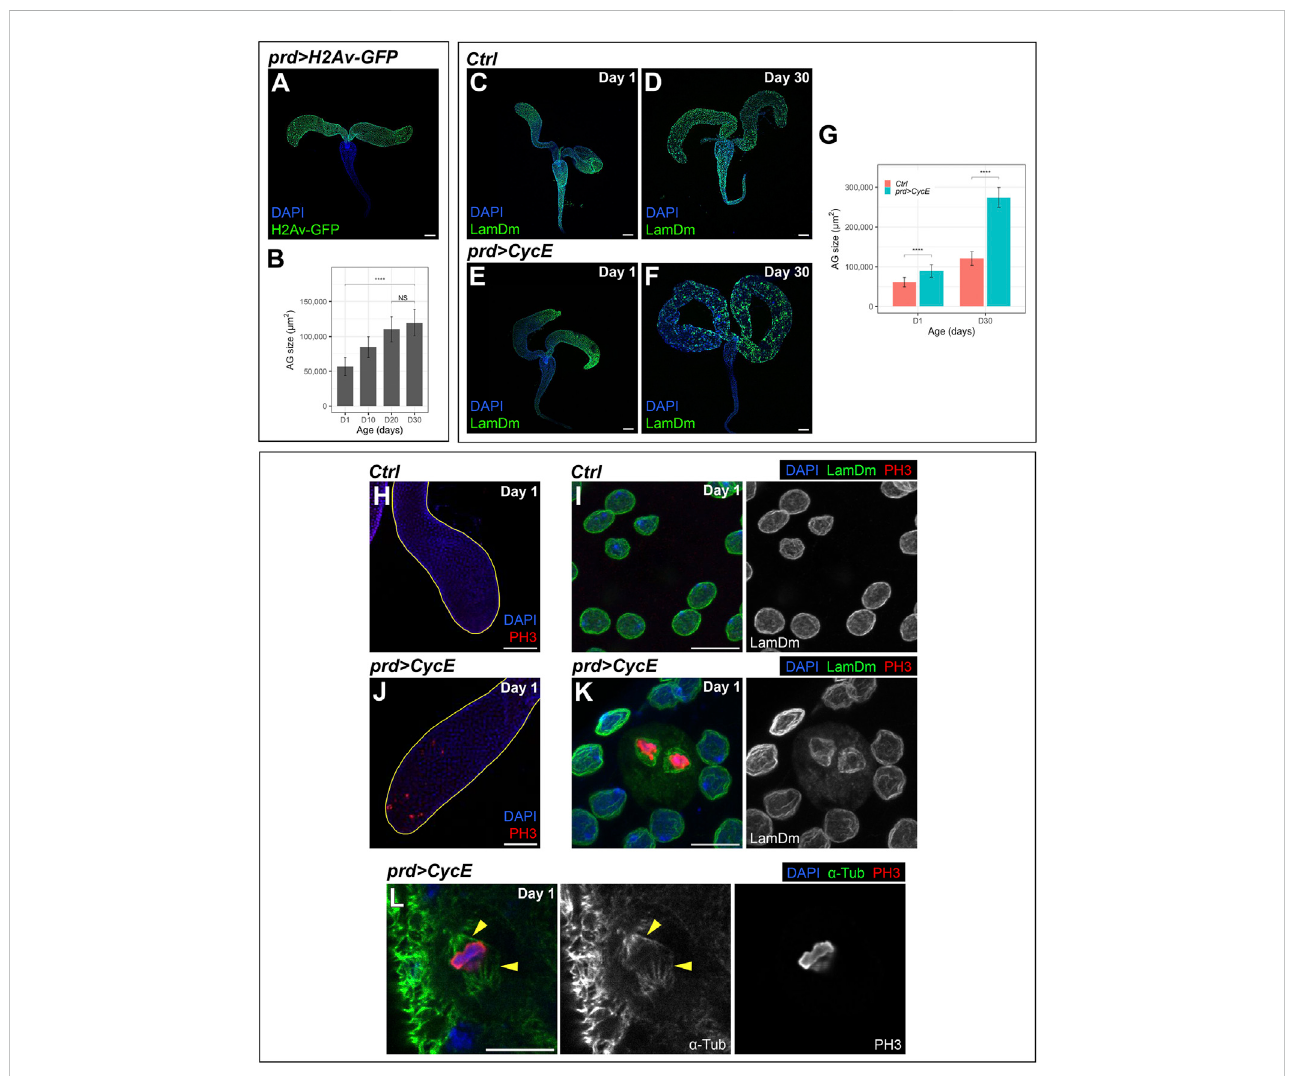
FIGURE 1 Cyclin E upregulation drives a size increase in the accessory gland. (A) Confocal image of an accessory gland that expresses H2Av-GFP under prd-Gal4 control. DAPI and H2Av-GFP are shown in blue and green, respectively. Scale bar, 100 µm. (B) Quanti fi cation of yw accessory gland (AG) size at days 1, 10, 20and30.Datashownaremean±SD.Statisticalanalysiswasperformedusingaone-wayANOVAfollowedbyaTukey ’ sHSDtest.Onlytherelevantsigni fi cant changes are shown. ****, p < .0001. NS, non-signi fi cant. (C – G) Confocal images of 1-day-old and 30-day-old control ( prd-Gal4/+ ) [ (C,D) , respectively] and prd > CycE [ (E,F) , respectively] accessory glands, and their size quanti fi cation (G) . Note that images in (C,E) were re-sized to have the same magni fi cation as (D,F) . In (C – F) , DAPI and LamDm are shown in blue and green, respectively. Data shown in (G) are mean ± SD. Statistical analysis was performed using a two-way ANOVA followed by a Tukey ’ s HSD test. Only the relevant signi fi cant changes are shown. ****, p < .0001. Scale bars, 100 µm. (H,J) Confocal images of 1-day-old control ( prd-Gal4/+ ) (H) and prd > CycE (J) glands stained with anti-PH3. Accessory glands are outlined in yellow. DAPI and PH3 are shown in blue and red, respectively. Scale bars, 100 µm. (I,K) Confocal images of 1-day old control ( prd-Gal4/+ ) (I) and prd > CycE (K) glands labeled with anti-Lamin Dm and anti-PH3. DAPI, LamDm and PH3 are shown in blue, green, and red, respectively. Scale bars, 10 µm. (L) Confocal image of a 1-day-old prd > CycE gland stained with anti-alpha-Tubulin ( α -Tub) and anti-PH3. The yellow arrowheads point to the mitotic spindle. DAPI, α -Tub and PH3 and shown in blue, green, and red, respectively. Scale bar, 10 μ